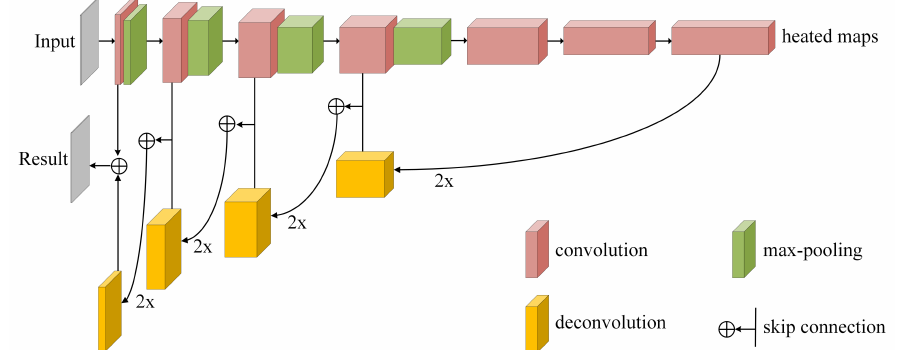
Figure 2. The framework of